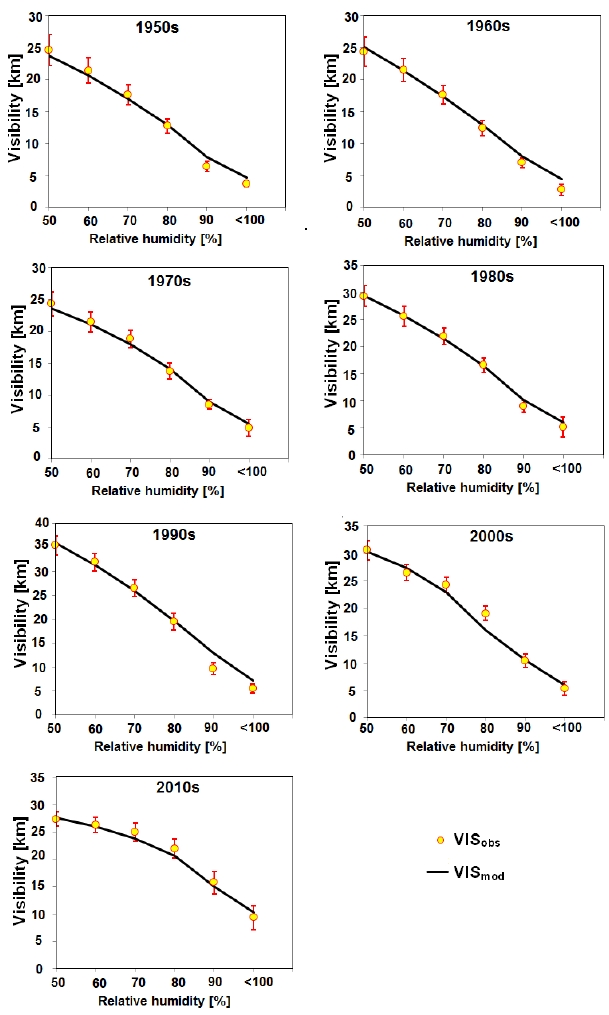
Figure 5. Comparisons of modelled and observed visibility in a spe- cific range of RH using Eq. (4) at Heathrow station. The observed visibility is presented with standard error bars at the 95% confi- dence